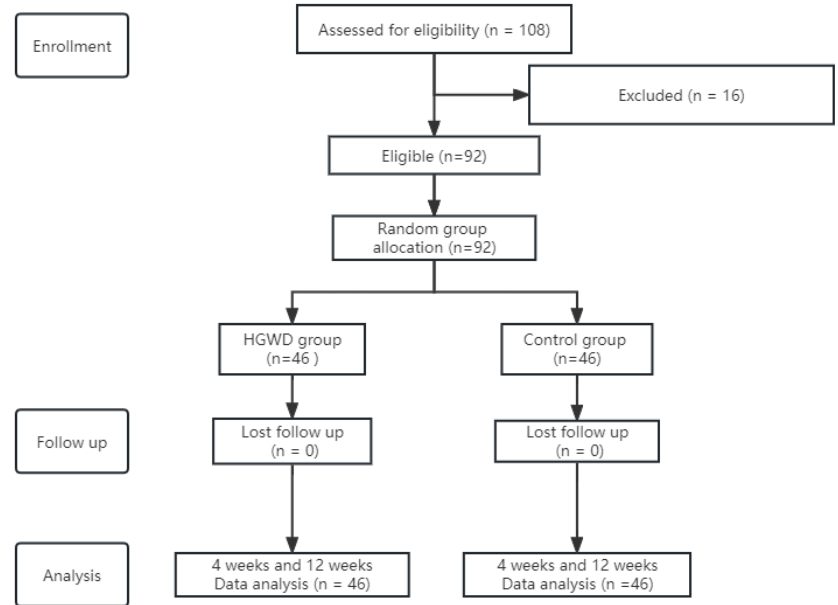
Figure 1. Patient selection of all patients in this study. Abbreviations: HGWD: Huangqi Guizhi Wuwu decoction.